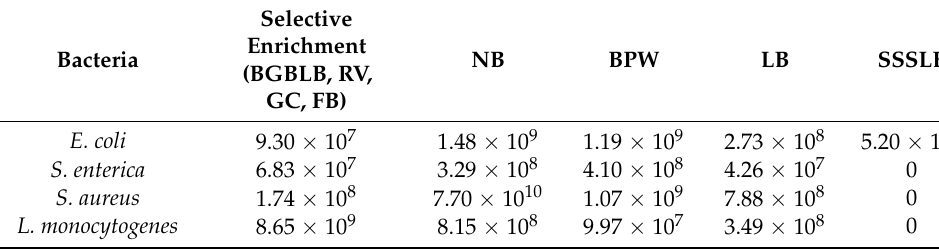
Table 2. Individual culture growth (CFU/mL).